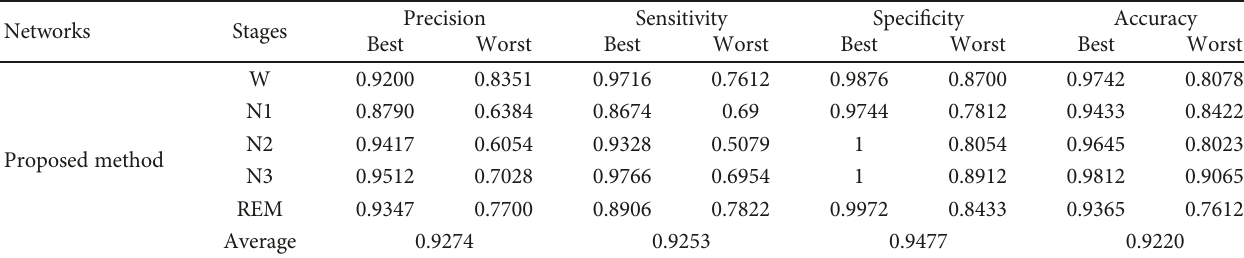
Figure 9: Confusion matrix comparison between Chambon et. al. [23] and fi ne-grained segments succeeding 30 s. Table 6: Evaluation results of our proposed method succeeding 30